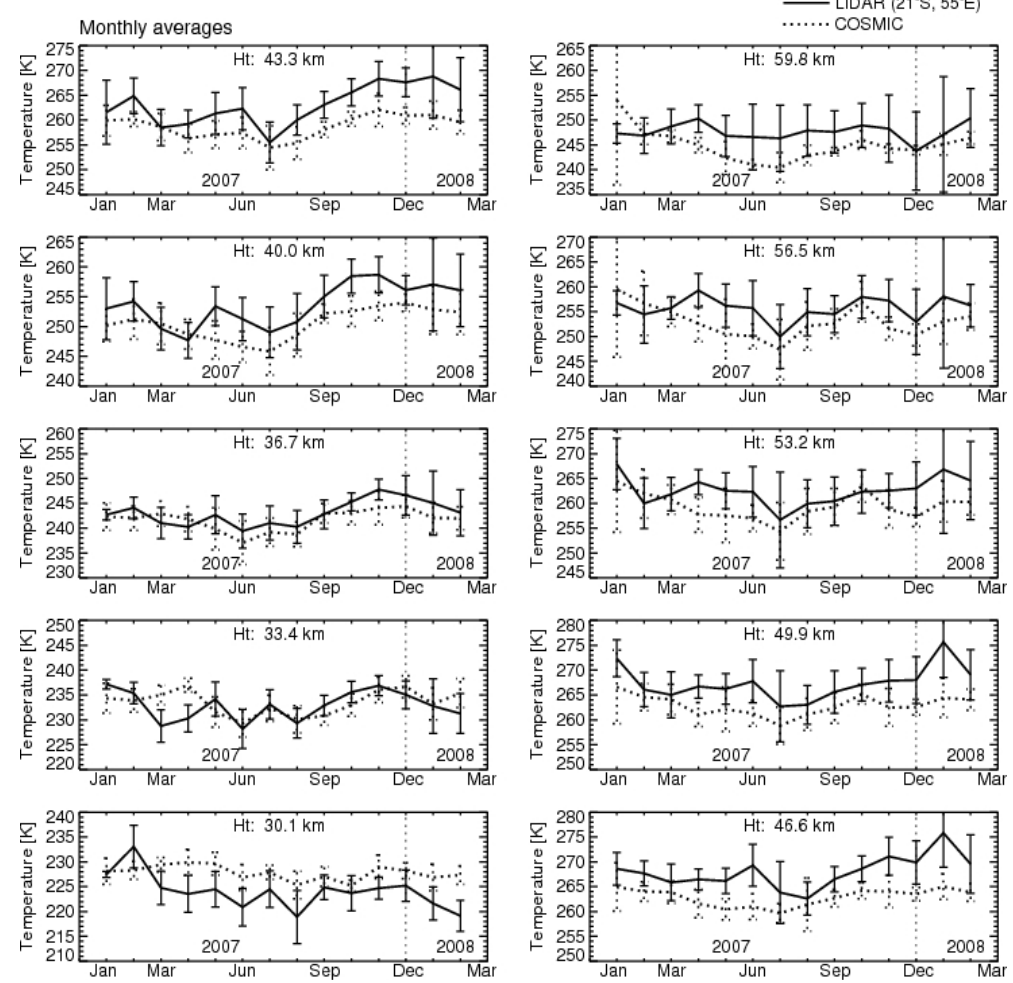
Fig. 8a. Inter-comparison of the monthly mean temperature values at selected heights between LIDAR and COSMIC observations for the year 2007 and Figure 8a: Inter-comparison of the monthly mean temperature values at selected heights 6 between LIDAR and COSMIC observations for the year 2007 and 2008. 7